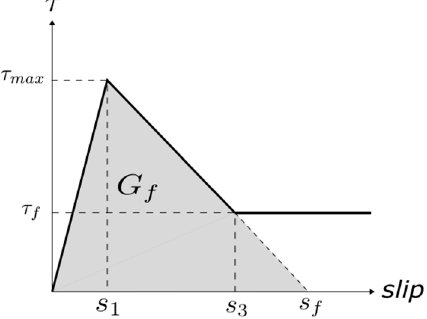
Figure 5. Fracture energy obtained from the bond–slip law.